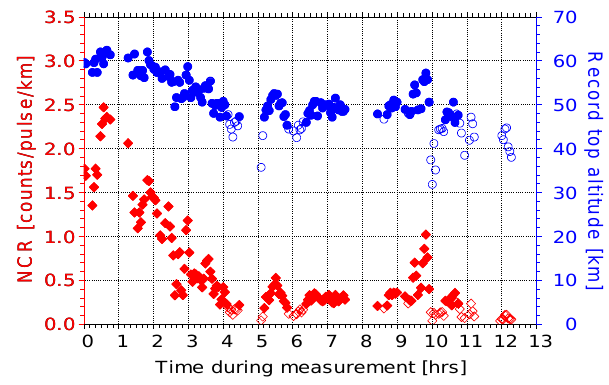
Fig. A1. Example of the record selection based on the nor- malised count rates (NCR) at 30km (red, left scale) and top altitude (blue, right scale) for the measurement from 05.02.2002 17:54UT– 04:42UT. Empty symbols mark records which are excluded from the signal summation (see text for